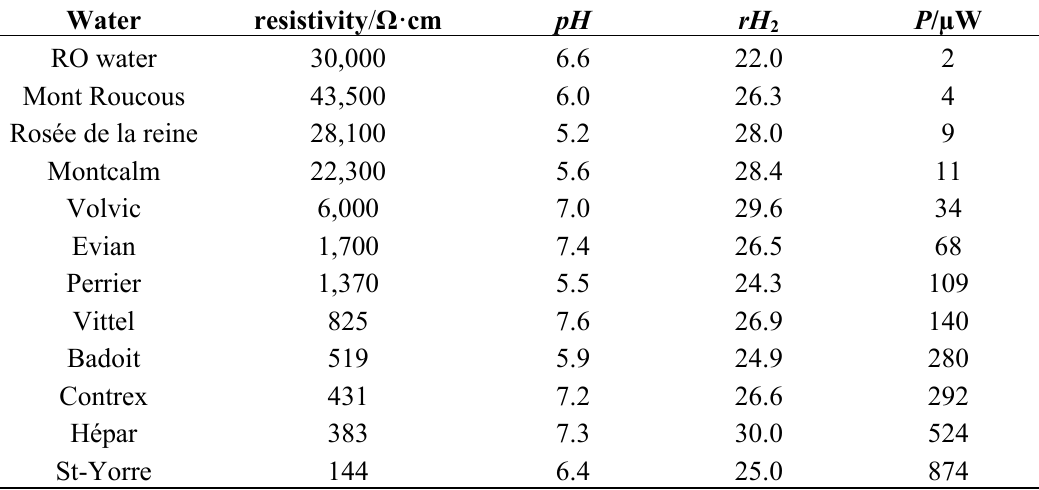
Table 3. Physicochemical characteristics of some French mineral water at T = 20 °C (RO = reverse